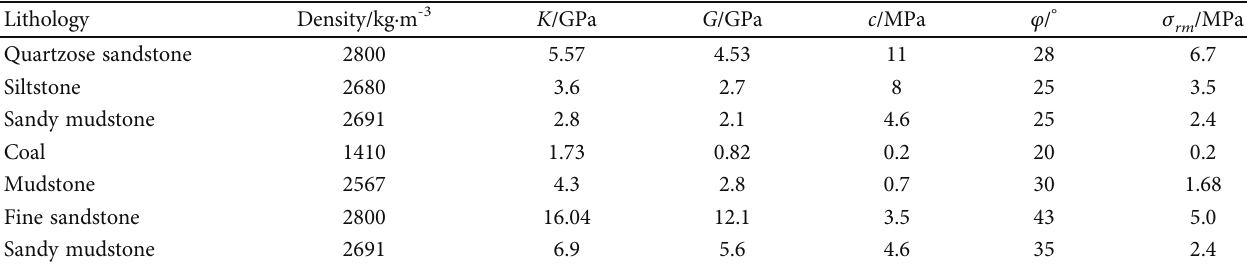
Table 2: Rock mass mechanical